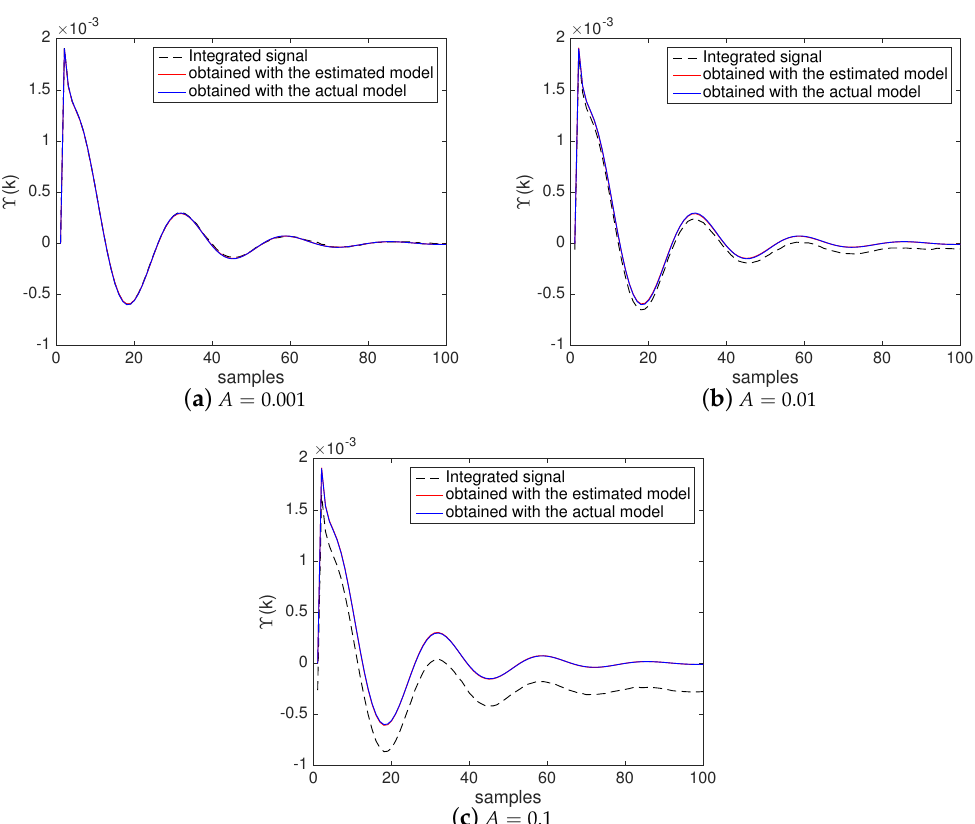
Figure 16. Examples of integrated signals and weighted impulse responses obtained through Algorithm 3 in scenarios with different amplitudes A